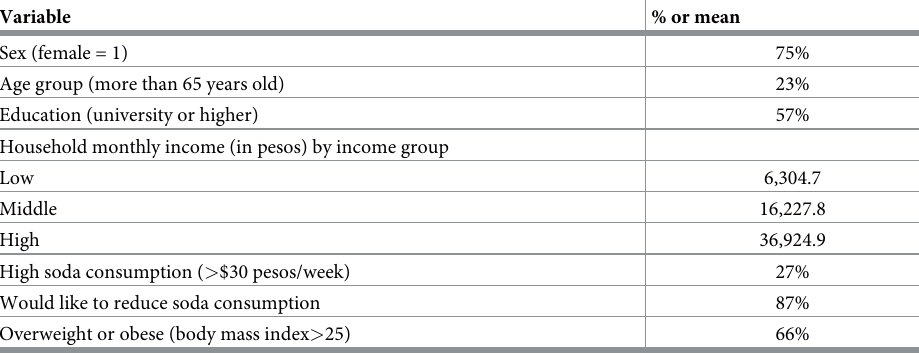
Table 1. Characteristics of the 471 participants.